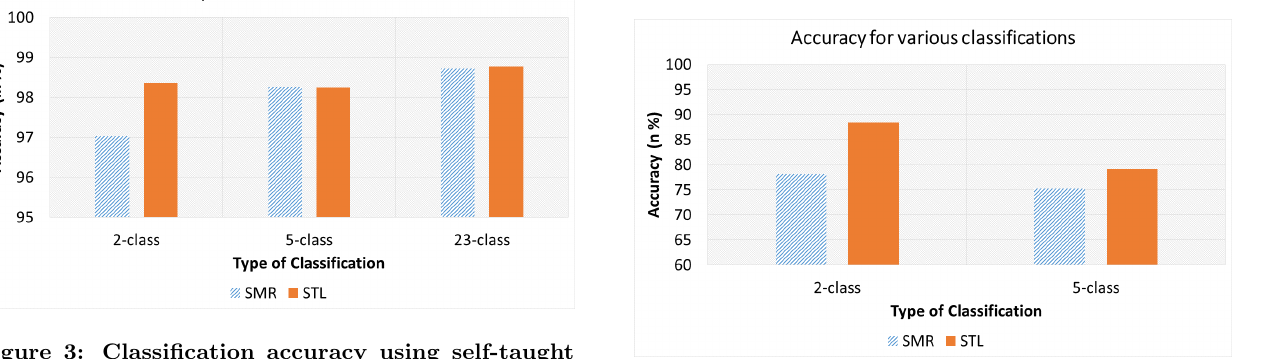
Figure 5: Classification accuracy using self-taught learning (STL) and soft-max regression (SMR) for 2-class and 5-class when applied to test data